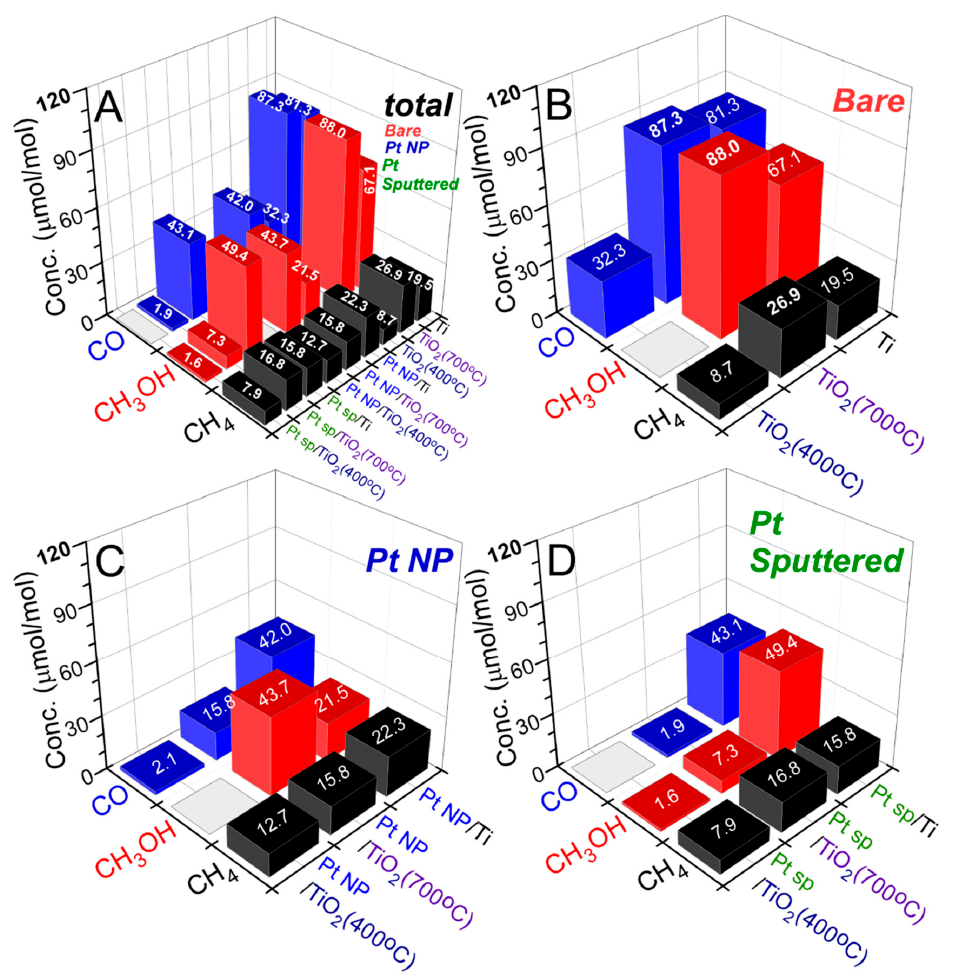
Figure 2. CO 2 reduction (CO, CH 4 , and CH 3 OH) yields ( µ mol / mol) over: ( B ) bare Ti, Ti (400 ◦ C), and Ti (700 ◦ C); ( C ) Pt NP / Ti, Pt NP / Ti (400 ◦ C), and Pt NP / Ti (700 ◦ C); ( D ) Pt-sp / Ti, Pt-sp / Ti (400 ◦ C), and Pt-sp / Ti (700 ◦ C) samples. ( A ) is the total plot for ( B – D ). CO 2 reduction mechanism is highly dependent on the production of protons and electrons [1,10].